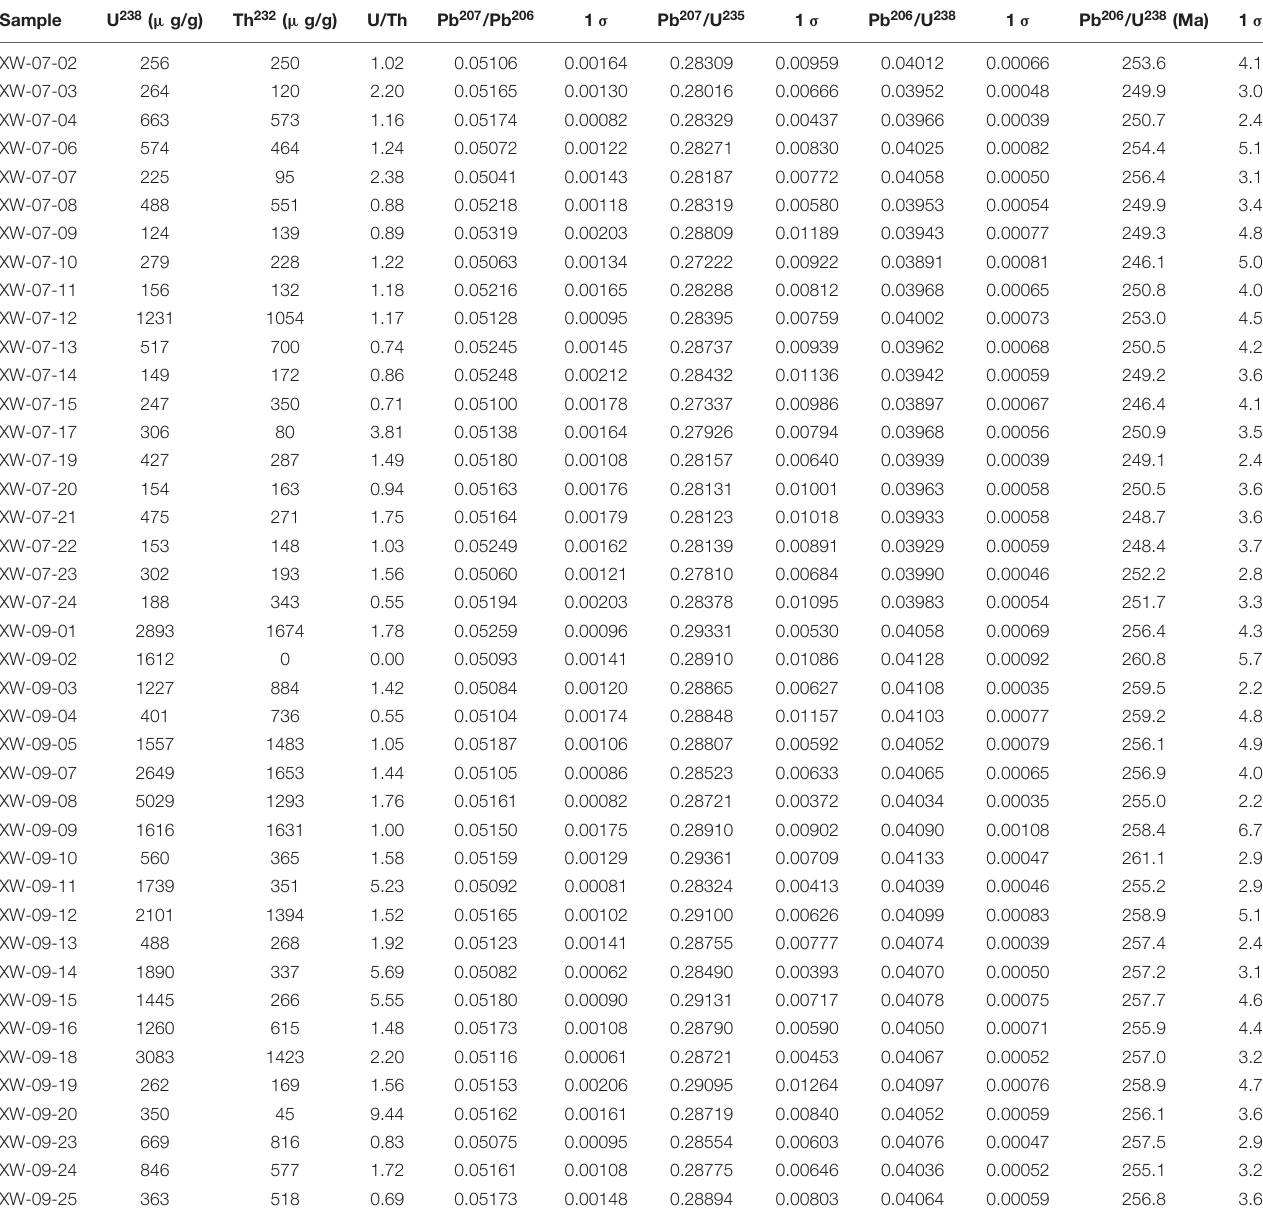
TABLE 1 | Concentrations of 238 U and 232 Th, and U–Pb isotopes of zircon from the Xiwanggou mafic–ultramafic complex.